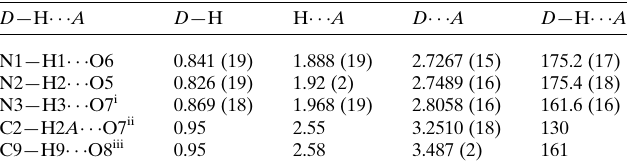
Table 3 Hydrogen-bond geometry (A˚ , (cid:4) ) for